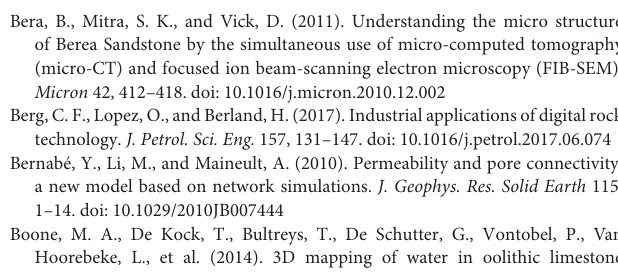
figshare. Fileset.